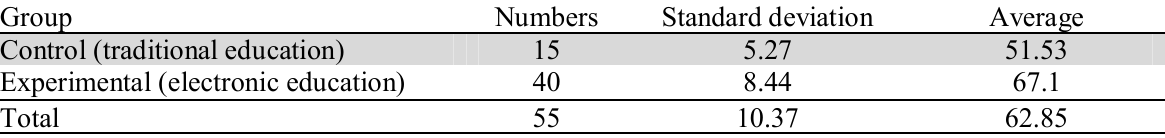
Descriptive results of posttest in the variable of mathematic learning quality in two groups of Control and Experimental Group